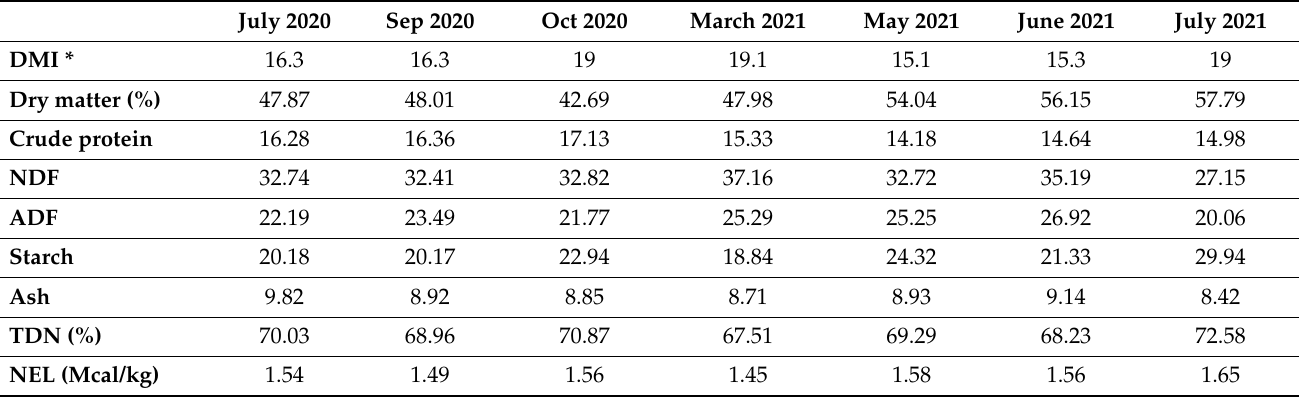
Table 3. Dry matter intake and NIRS analysis of TMR across sampling times. The TMR was composed of a mix of soybean meal, alfalfa hay, mineral, grass silage, corn silage and corn